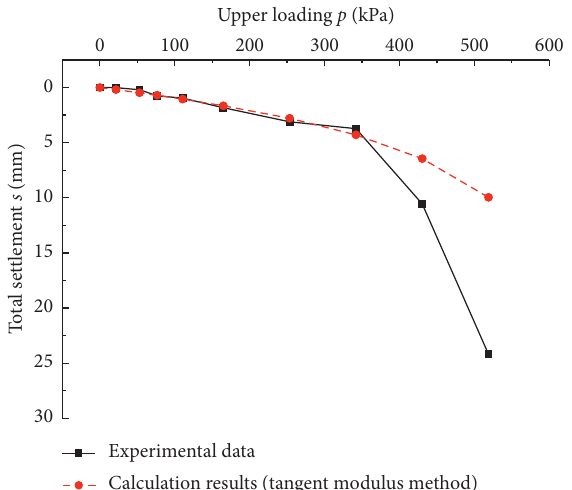
Figure 12: Comparison between calculated settlements and ex- perimental data for the single pile composite